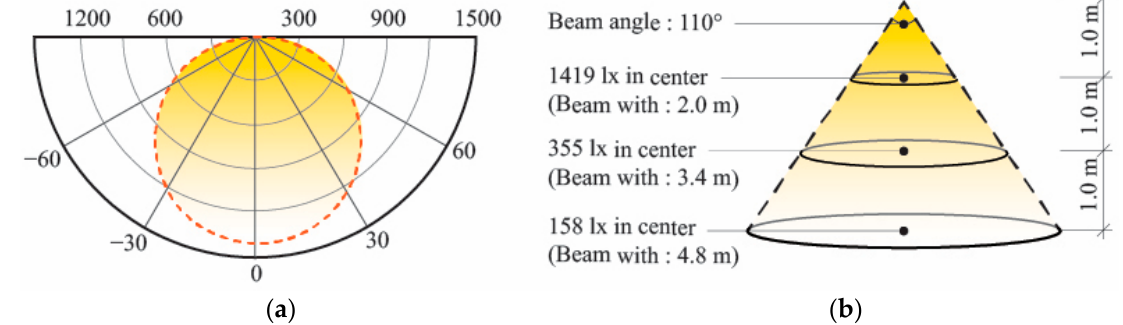
Figure 5. The light distribution curve and conical illuminance of lighting. ( a ) Light distribution curve. ( b ) Conical illuminance.